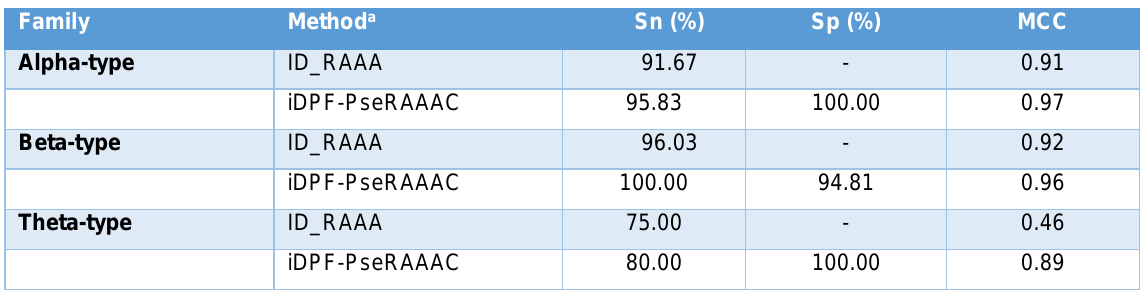
Table 5: Performance comparison of ID_RAAA and iDPF-PseRAAAC for the prediction of vertebrate defensins